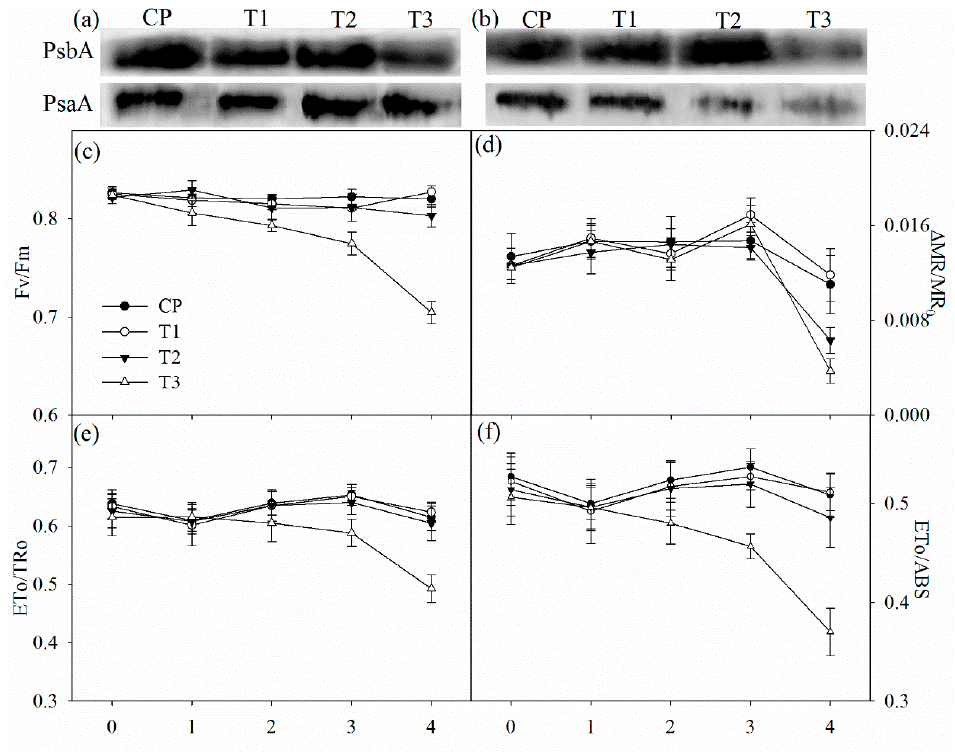
Figure 4. Immunoblot analysis of PSII reaction center protein (PsbA) and PSI reaction center protein (PsaA) abundance after two days ( a ) and four days ( b ) of salt stress and salt-induced changes in the maximal photochemical efficiency of PSII (Fv/Fm, ( c )) and PSI ( Δ MR/MR 0 , ( d )), probability that an electron moves further than Q A (ETo/TRo, ( e )) and quantum yield for electron transport (REo/ETo, ( f )) in Jerusalem artichoke. Data in the figure indicate the mean of five replicates (±SD).